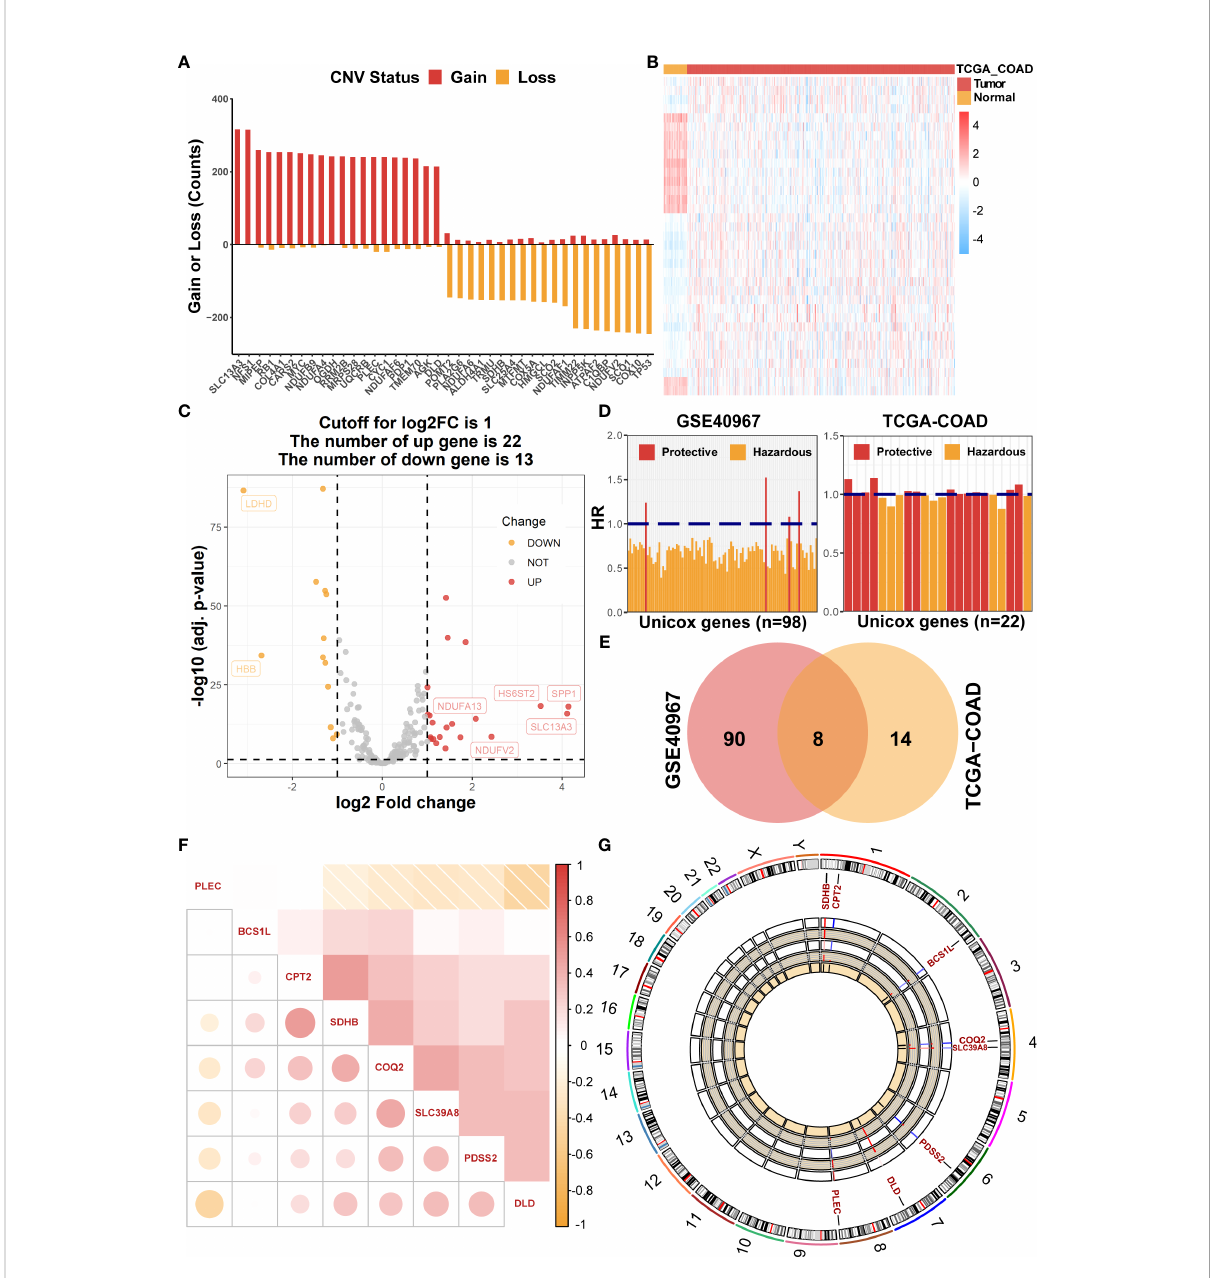
FIGURE 1 Identi fi cation of prognostic LMRGs in COAD patients. (A) The global CNV frequency of LMRGs in the TCGA-COAD cohort. (B) The heat map of differentially expressed LMRGs between adjacent and tumor samples in TCGA-COAD. (C) The volcano plot presenting differentially expressed genes among LMRGs. (D) OS-related LMRGs in GSE40967 and TCGA-COAD cohorts, respectively. (E) The Venn diagram to identify eight intersected prognostic LMRGs. (F) The correlation matrix plot exhibiting eight candidate LMRGs. (G) The Circos plot to illustrate regions on chromosomes and expressions of eight candidate